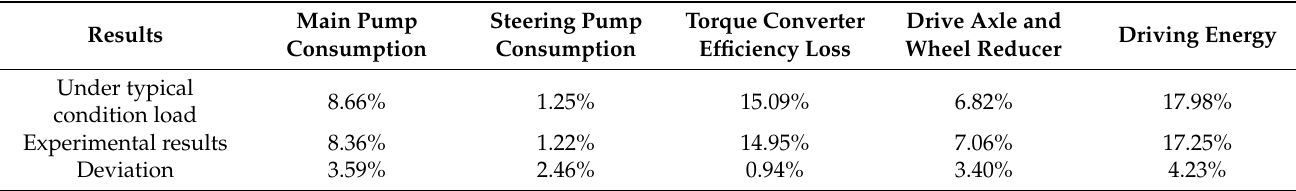
Table 8. The transportation condition energy flow comparison